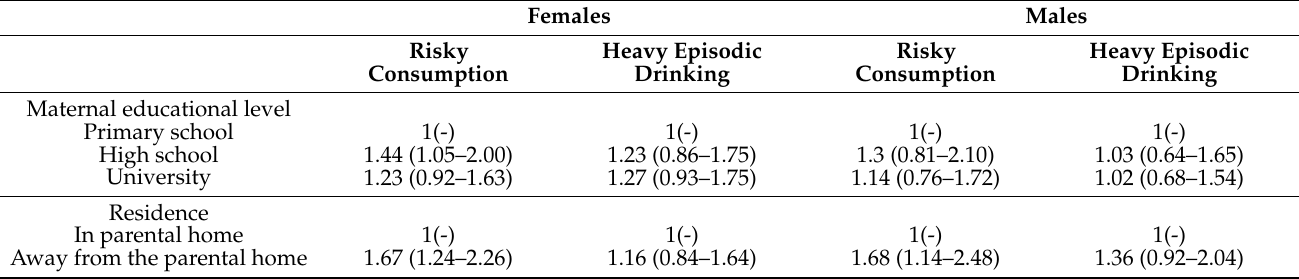
a Results of multivariate logistic regression adjusted for all variables included in the table. Table 5. Influence of explanatory factors on Risky consumption and Heavy episodic drinking among male and female students in 2016. Results are presented as adjusted odds ratio (95%CI) a